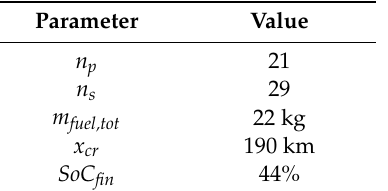
Table 3. Final values of Problem 1.